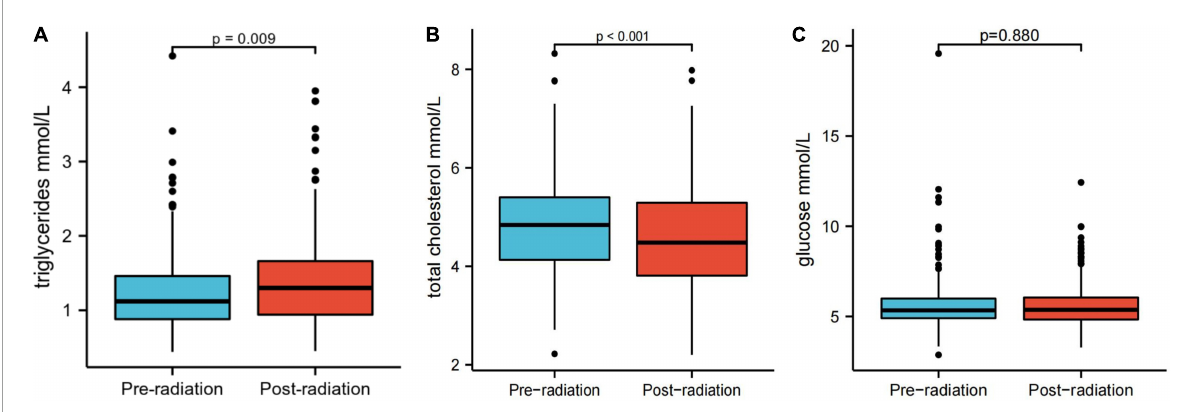
FIGURE1 Serum triglyceride (A) , total cholesterol (B) , and glucose levels (C) before and after